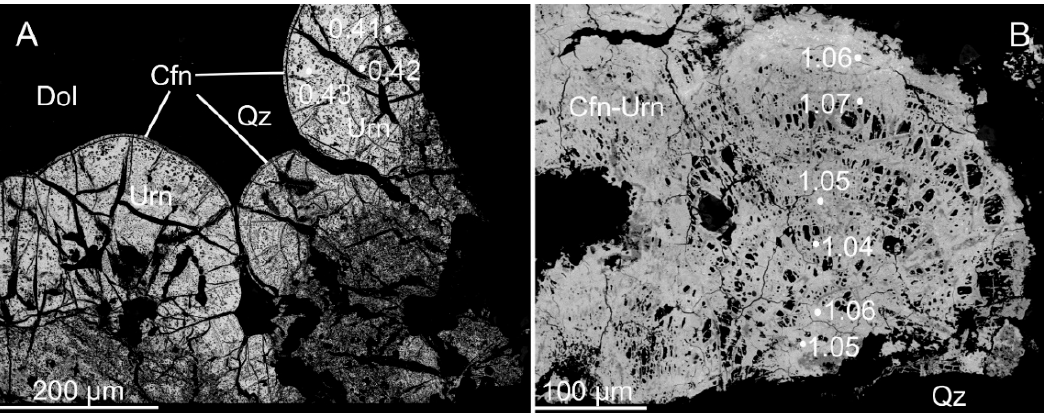
Figure 10. BSE images of coffinite and coffinitized uraninite with distribution of Si ( apfu , O = 4), Jáchymov uranium district. ( A ) Distribution of Si in partly coffinitized uraninite; ( B ) Detailed distribution of Si in botryoidally evolved uraninite. Urn—uraninite, Cfn—coffinite, Cfn-Urn—coffinitized uraninite, Dol—dolomite,